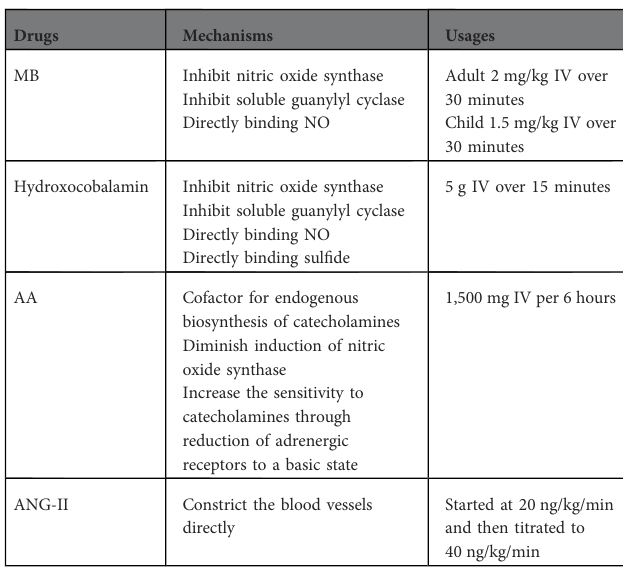
TABLE 2 Risk factors of VS in patients undergoing HTX. TABLE 3 Mechanisms and usages of the four